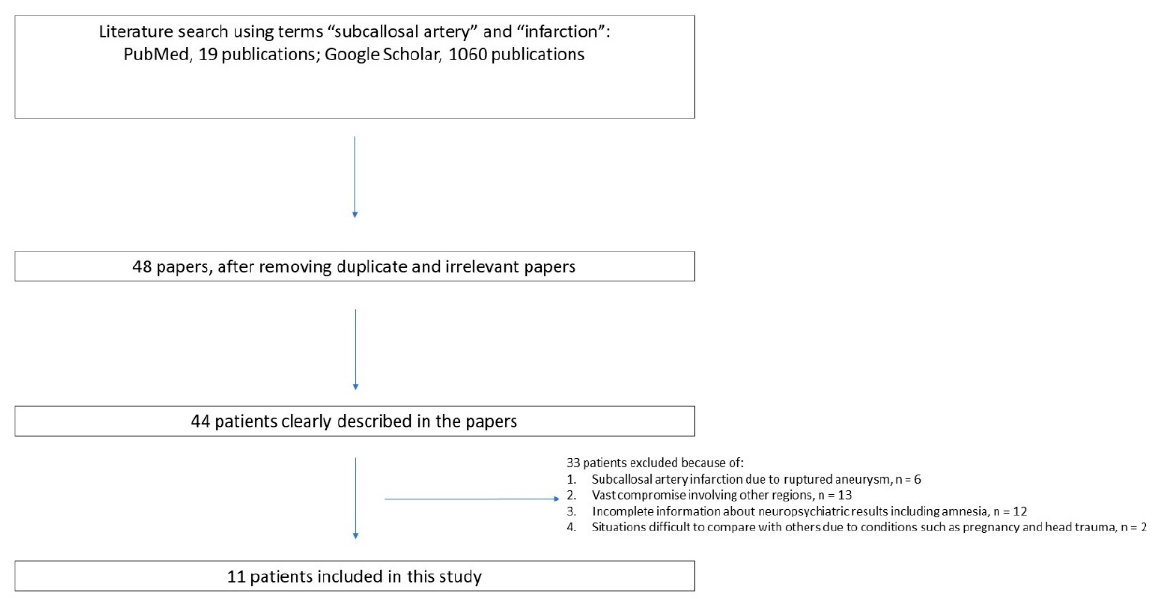
Figure 1. Systematic review flow diagram of this study.